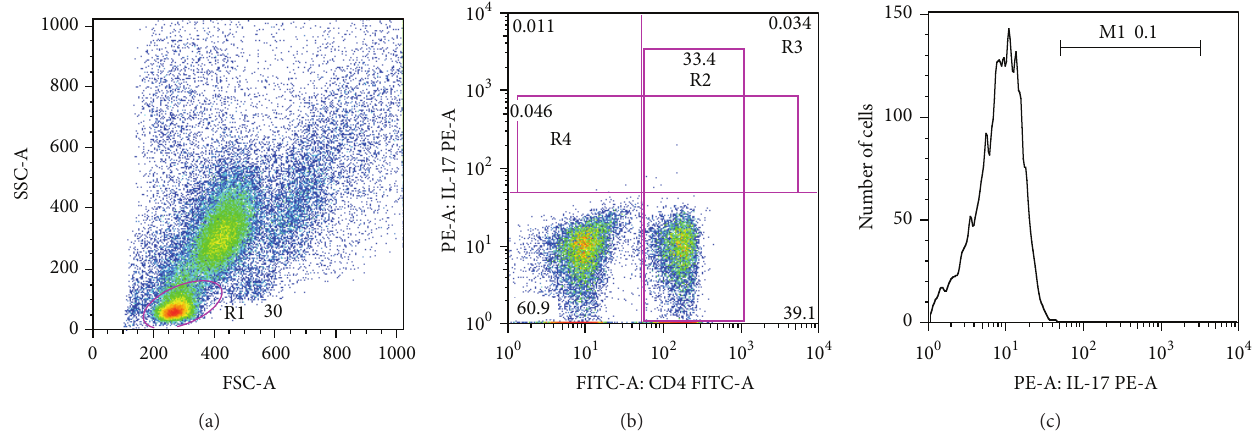
Figure 1: Representative flow cytometry graphs of CD4 + lymphocytes expressing intracellular cytokine IL-17A. Flow cytometry dot-plots demonstrate the lymphocyte region (R1) selected (a) and the data analyzed in total CD4 + T cells (R2) (b). A single-color histogram (M1) (c) expressing IL-17A in the CD4 + T cells was obtained from the R2 region (c). Double-positive CD4 + IL-17A + in total lymphocytes (R3) and total IL-17A production (R4) were also analyzed in a dot-plot graphic